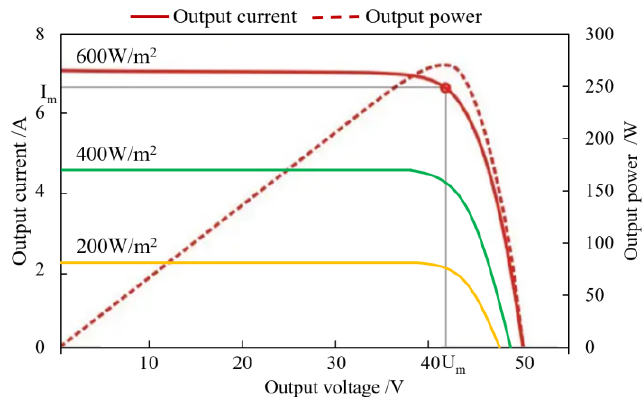
Figure 7. Volt – ampere characteristic curve of the solar PV module. Figure 7. Volt–ampere characteristic curve of the solar PV module.